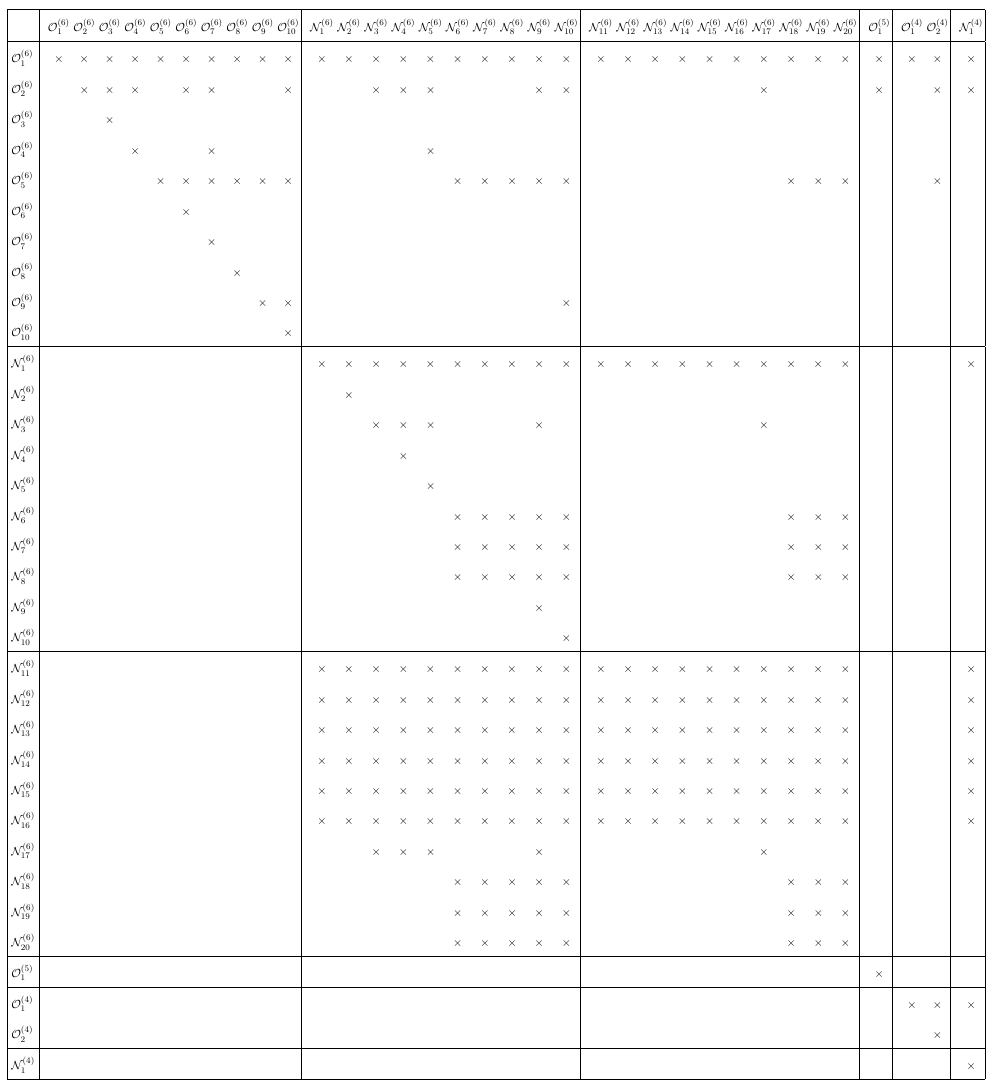
is the CP -odd three-gluon operator. 1 does not mix into the QCD (cid:22) (cid:18) term O (4) 2 1